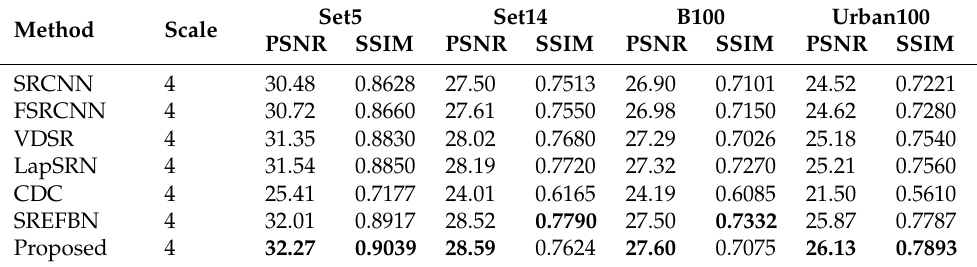
Table 3. Quantitative comparison of 4 × super-resolution results obtained by different methods.